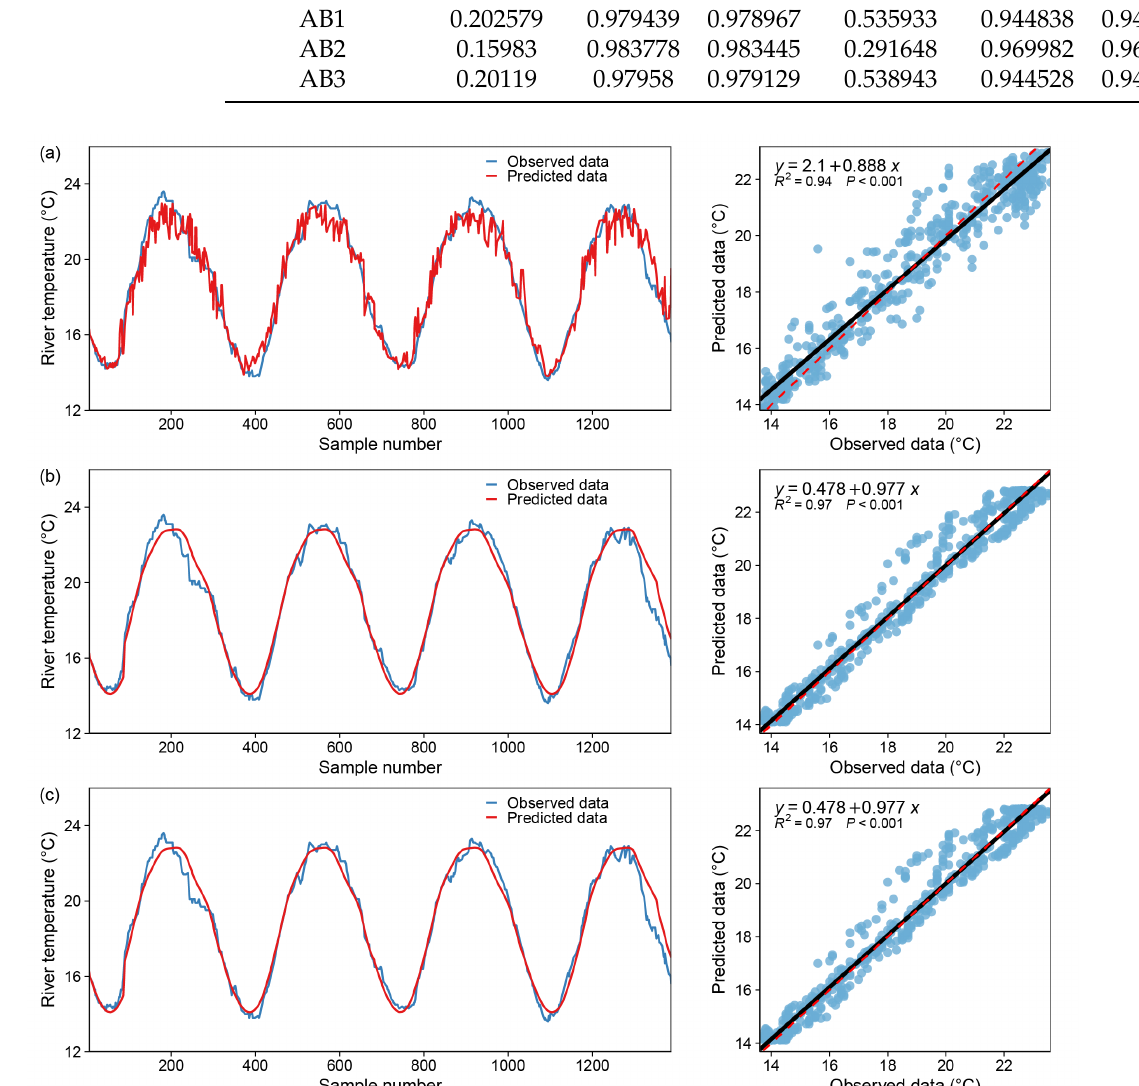
Figure 11. Model fitting results—SupportVector Regression, blue dot: X coordinate (observed data), Y coordinate (predicted data) ; black line: y = x ; red dotted line: the regression curve of the blue dots. ( a ) only one input variable (DOY), ( b ) with two input variables (DOY and Flow), ( c ) with all